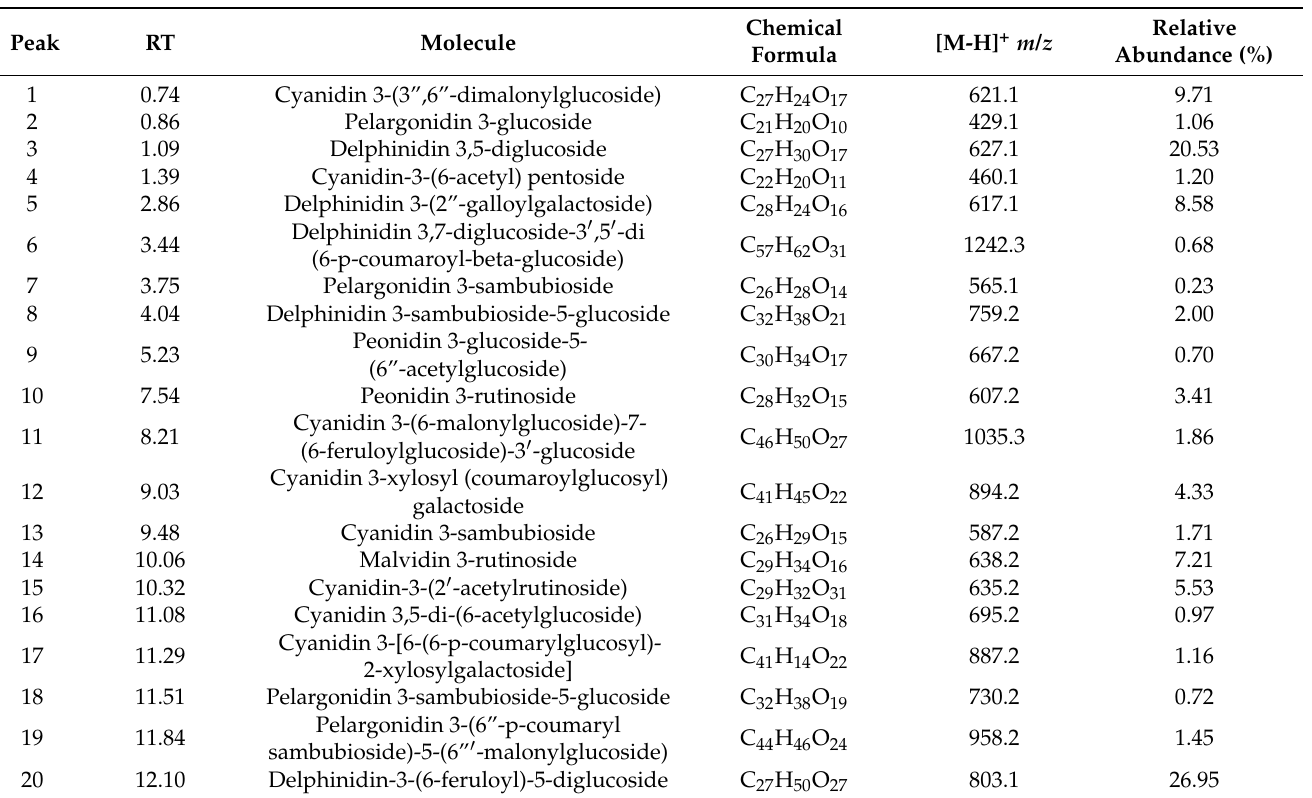
Table 2. Anthocyanins identified by HPLC-MS/MS analysis for aqueous extracts of fruit and in vitro plant of A. chilensis